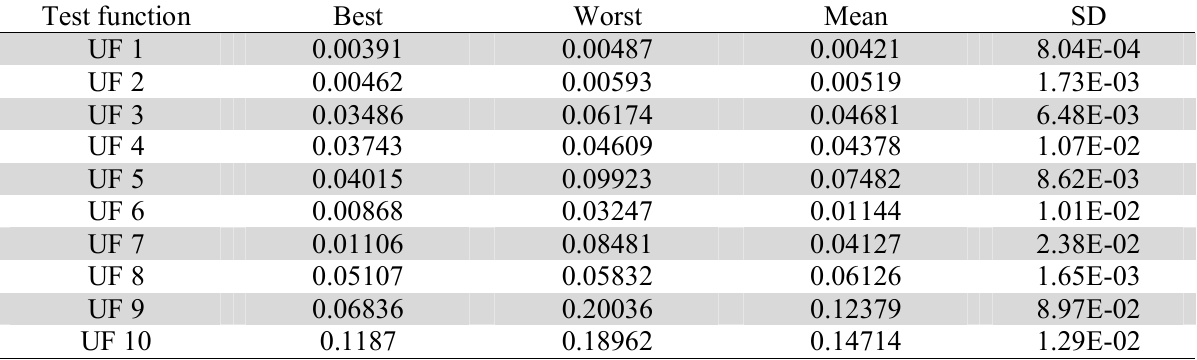
IGD values obtained with MO-ITLBO for different unconstrained test functions (UF1-UF10) in 30 independent runs.